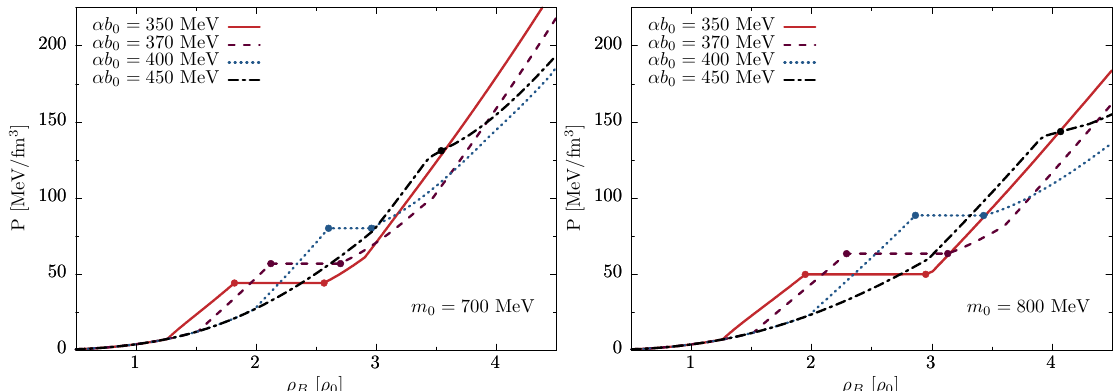
Figure 1. Thermodynamic pressure P as a function of the net-baryon number density ρ B , in units of the saturation density, ρ 0 = 0.16 fm − 3 for m 0 = 700 MeV ( left ) and m 0 = 800 MeV ( right ). The regions between circles correspond to the coexistence of chirally broken and restored phases in the first-order phase transition. For α b 0 = 450 MeV, the transition is a crossover. The deconfinement transitions are triggered at higher densities and are not shown here.